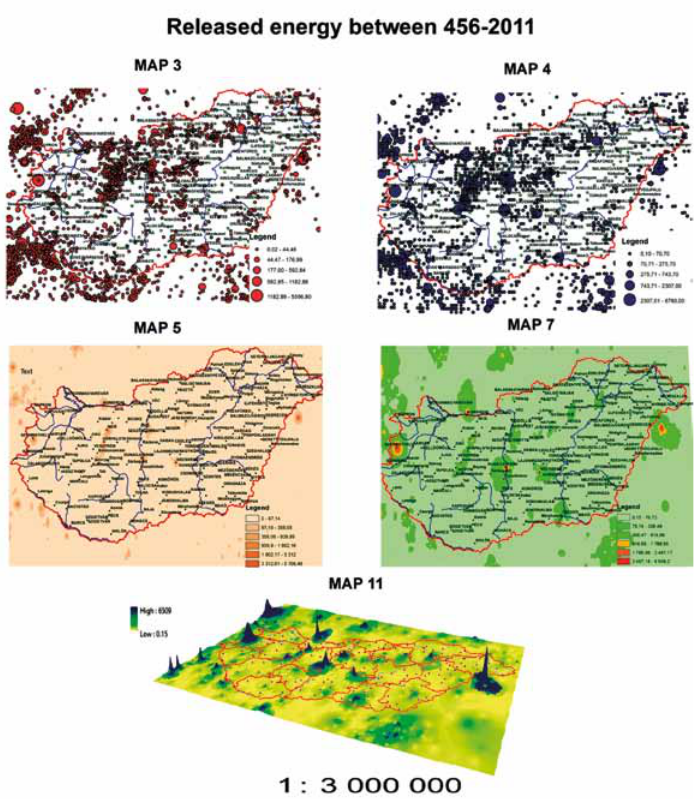
Fig. 1. Test maps depicting the amount of released energy of earthquakes